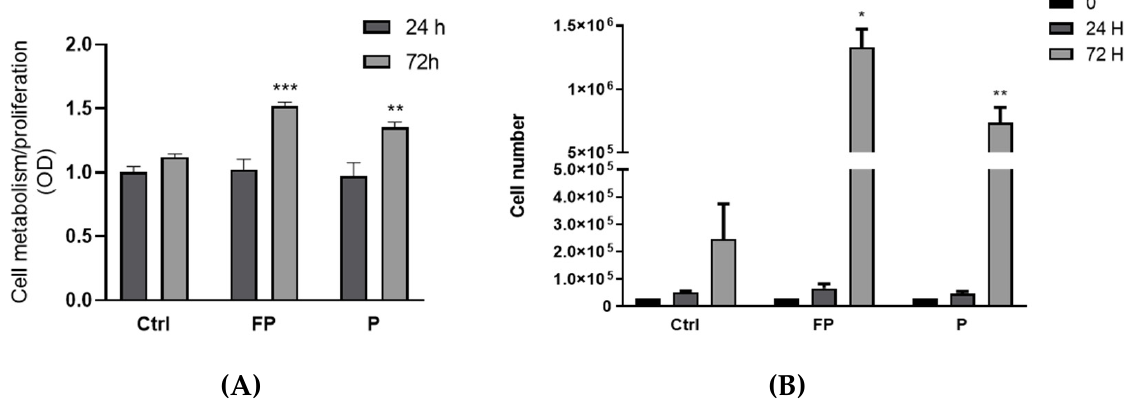
Figure 7. ( A ) RAW 264.7 cells were plated in 24-wells plates (3.0 x 10 4 cells/well), treated with 10 µg/mL of FP or P and further incubated for 24 and 72 h. At the end of treatment cells were incubated at 37 ° C, 5% CO 2 for 3 h with Alamar Blue solution. Optical density (OD) was determined with a spectrophotometer at 570 nm. ( B ) RAW 264.7 cells were seeded in 24-well plates (3.0 × 10 4 cells/well) and treated with 10 µg/mL of FP and P and further incubated for 24 and 72 h. At the end of incubation, cell number was determined with the Burker chamber utilizing Trypan Blue as a cell dye. Results are expressed as mean ± SD of at least three experiments. * p < 0.05 ** p < 0.01 *** p < 0.001 significantly different from the control at 72 h (ctrl). Ctrl (control, not treated cells); FP (cells treated with fermented Pushgay); P (cells treated with Pushgay).